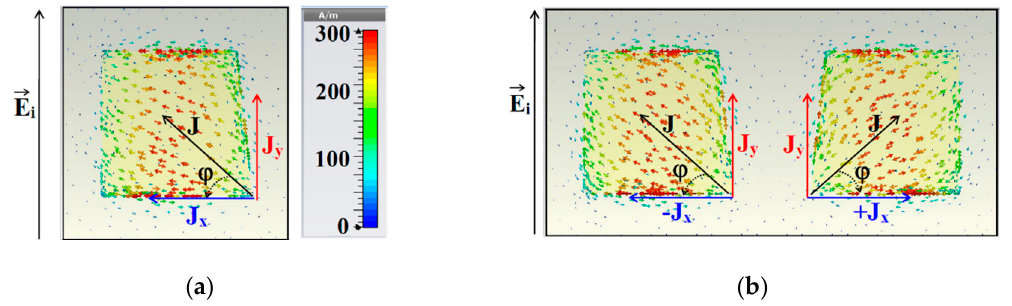
Figure 4. ( a ) Surface current flow on asymmetric patch element; ( b ) Two asymmetric patch elements in mirror orientation.